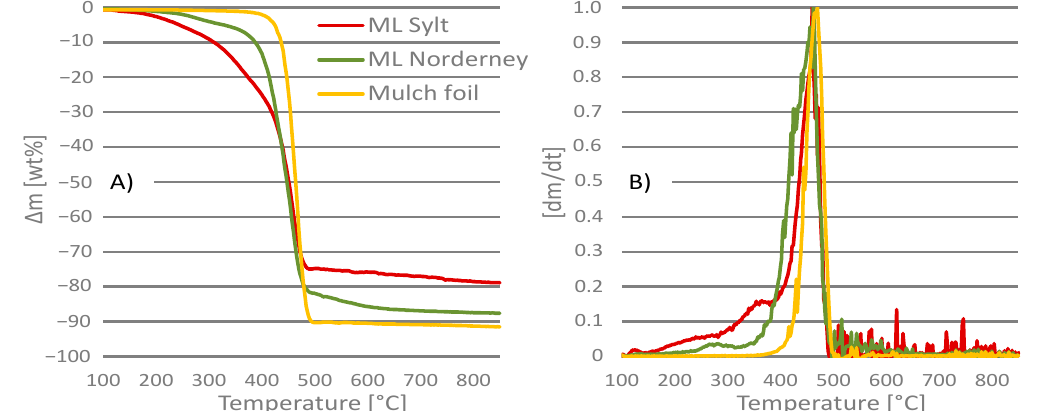
Figure 6. ( A ) shows the thermogravimetric analysis (TGA) mean value of pyrolysis. ( B ) shows the standardised derivative of TG (DTG) signal. (ML Sylt n = 5, ML Norderney n = 5, Mulch foil n = 4).